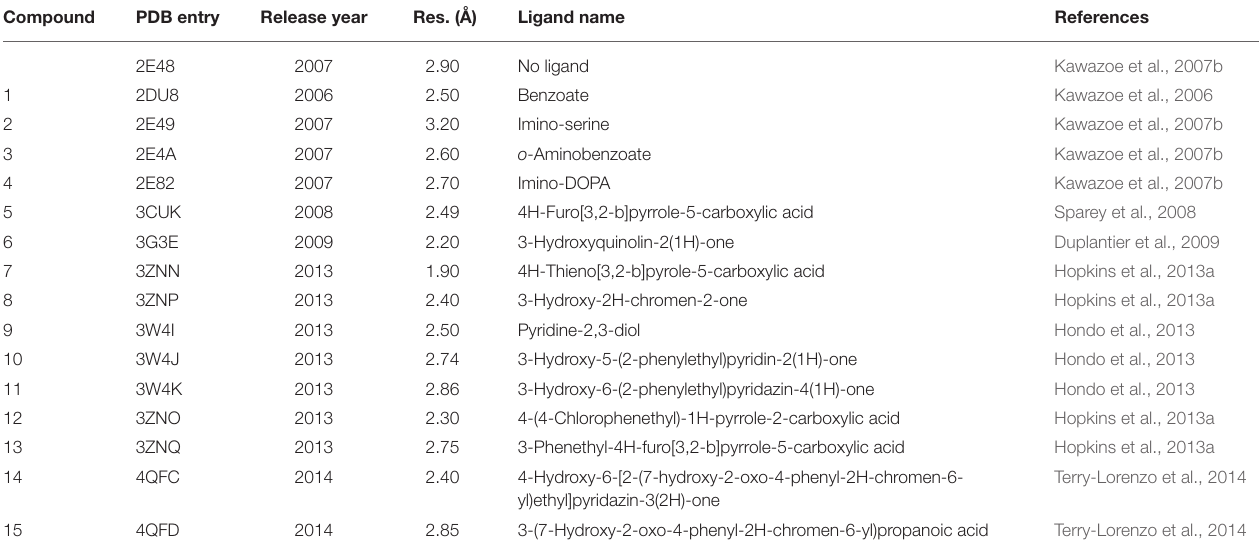
TABLE 1 | Experimental 3D structures of human DAAO available in the Protein Data Bank. Compound